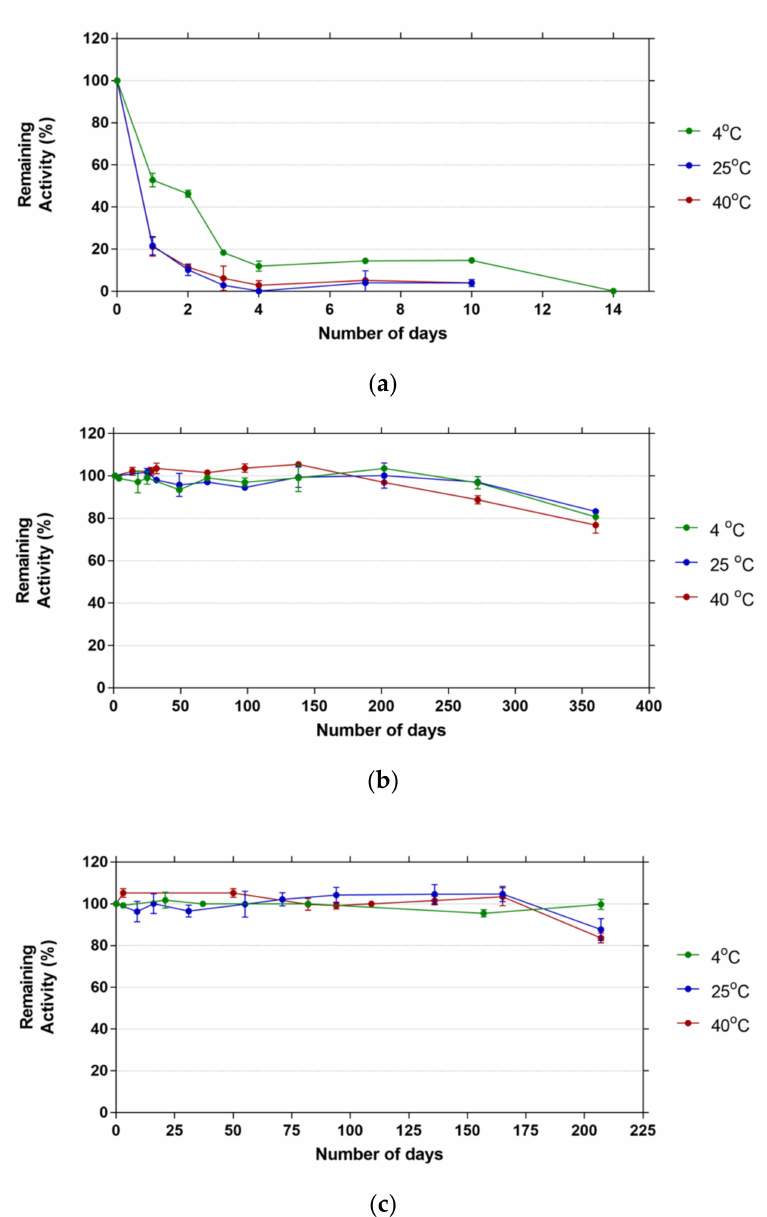
Figure 8. Remaining activity (%) after storage at different temperatures (4 ◦ C, 25 ◦ C and 40 ◦ C) of ( a ) the A. platensis lysate, ( b ) the bottom phase of ATPS and ( c ) the hydrogel that was formulated with A. platensis lysate. 100% proteolytic activity refers to the measurement at Day 0, using azocasein as substrate. Measurements were performed in triplicate, and the data present the mean ± SD (N =